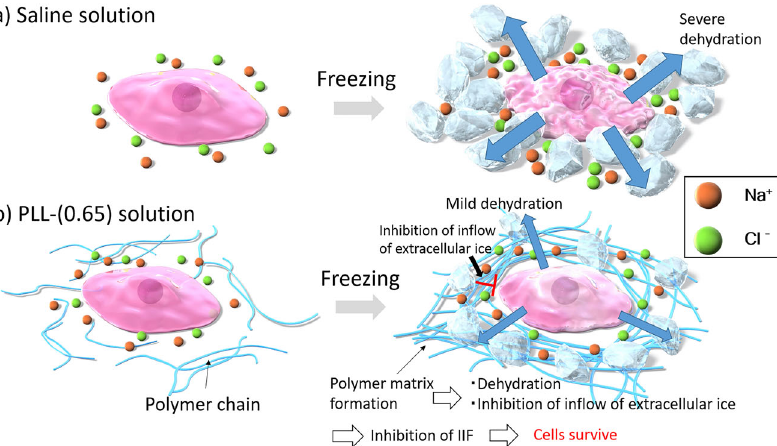
Fig. 7 Schematic illustration of the mechanism of cryoprotection by PLL-(0.65). a When the cells are frozen in saline solution, excessive cell dehydration occurs because of the severe freezing concentration, leading to lethal dehydration damage. b When the cells are frozen with PLL-(0.65), the polymer molecules aggregate because of strong intermolecular electrostatic interactions caused by freeze concentration, thereby trapping ions and water in the matrix to reduce any dramatic osmotic change. The viscous polymer matrix inhibits the in fl ow of extracellular ice to avoid